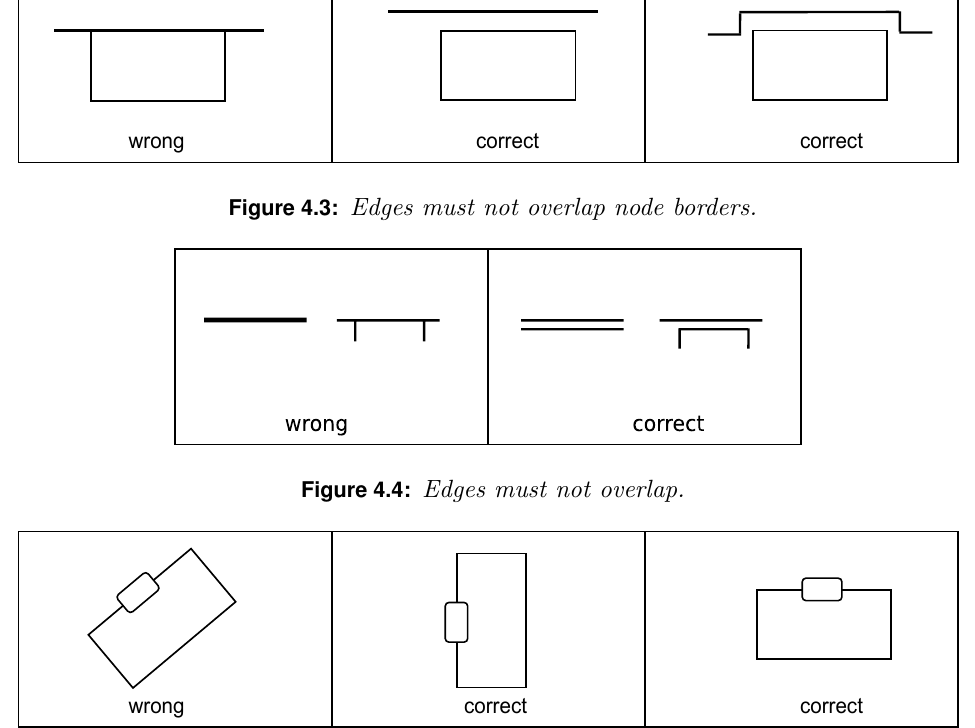
Figure 4.5: The node orientation must be horizontally or